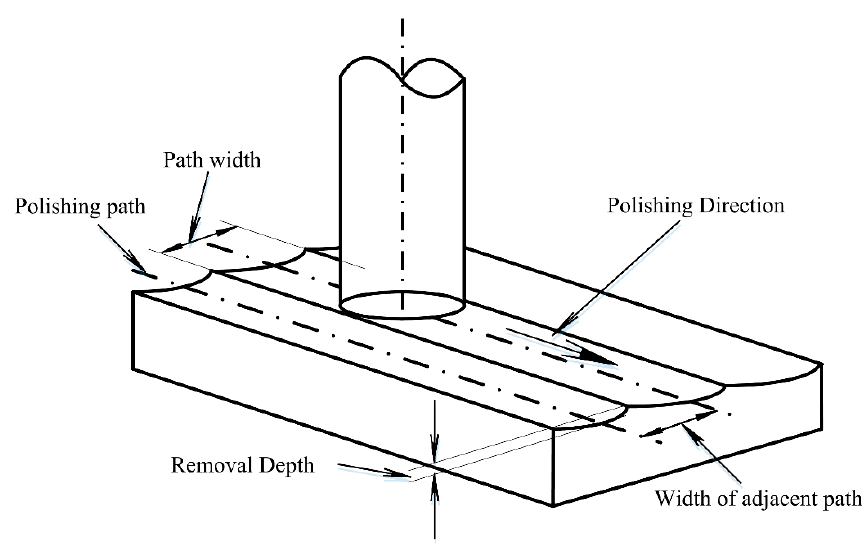
Figure 2. Schematic diagram of the surface waviness error generation mechanism.